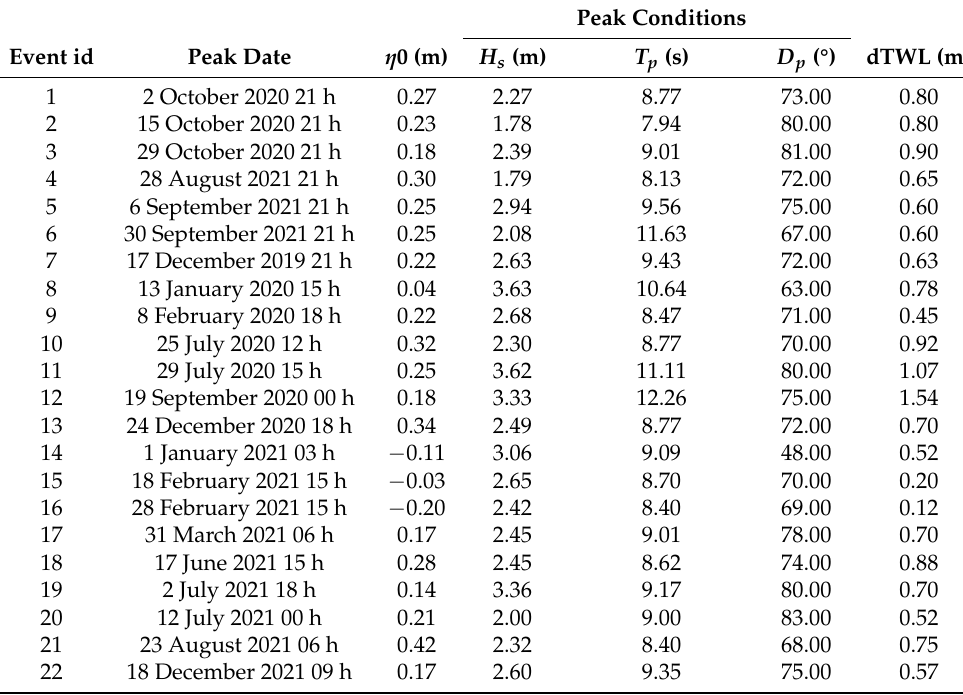
Table 1. Hydrodynamic inputs used for XB-NH model validation. It comprises peak conditions for the still water level ( η 0), the significant wave height ( H s ), the peak wave period ( T p ), the peak wave direction ( D p ) and the daily maximum still water level (dTWL) Peak Conditions Event